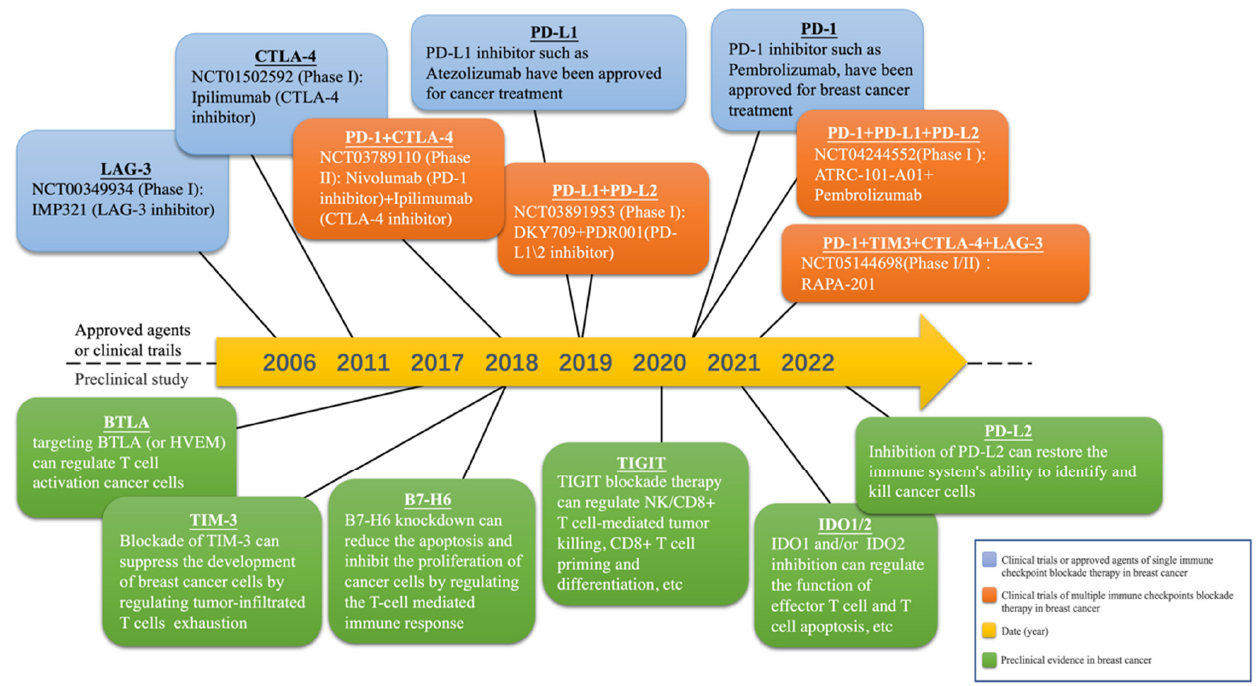
Figure 1. Milestones of selected immune checkpoint blockade therapy utilized in treating breast cancer. Currently, four clinical trials are testing different multiple immune checkpoint blockade therapy in breast cancer. The therapeutic value of seven novel immune checkpoint suppression methods in breast cancer treatment has been reported by preclinical studies.